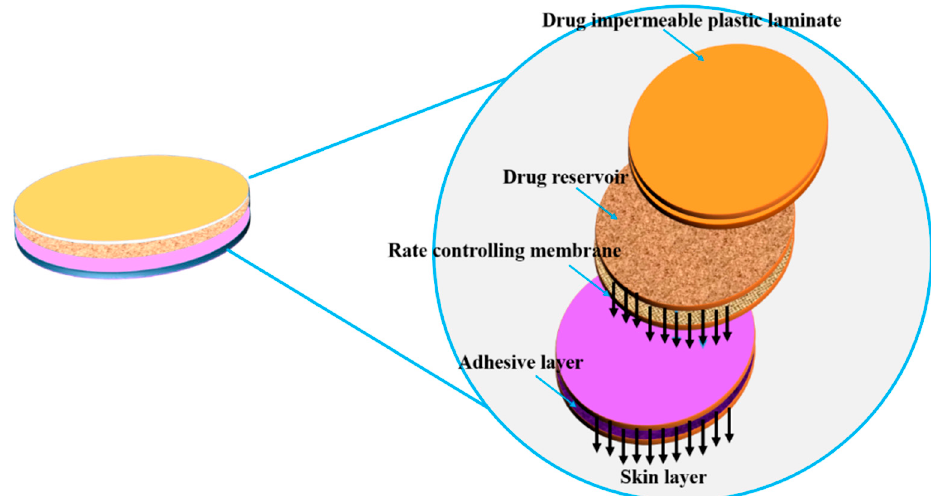
Figure 13. Diagrammatic representation of membrane permeation-controlled system in which the drug reservoir is sandwiched between the membrane layers and the adhesive layers facing the skin’s surface (adapted from [134]).